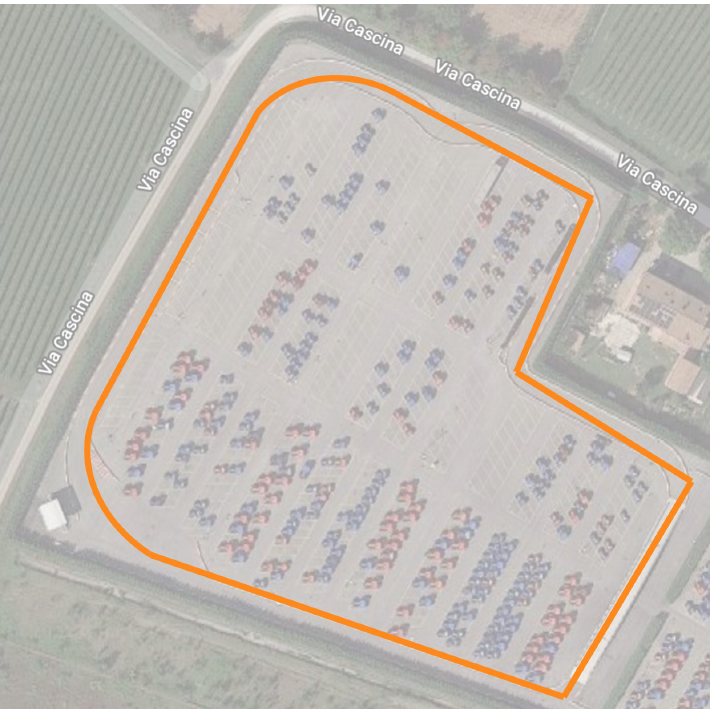
Figure 9. Circuit considered in the road calibration tests (Argo Terminal, Fabbrico, Italy).